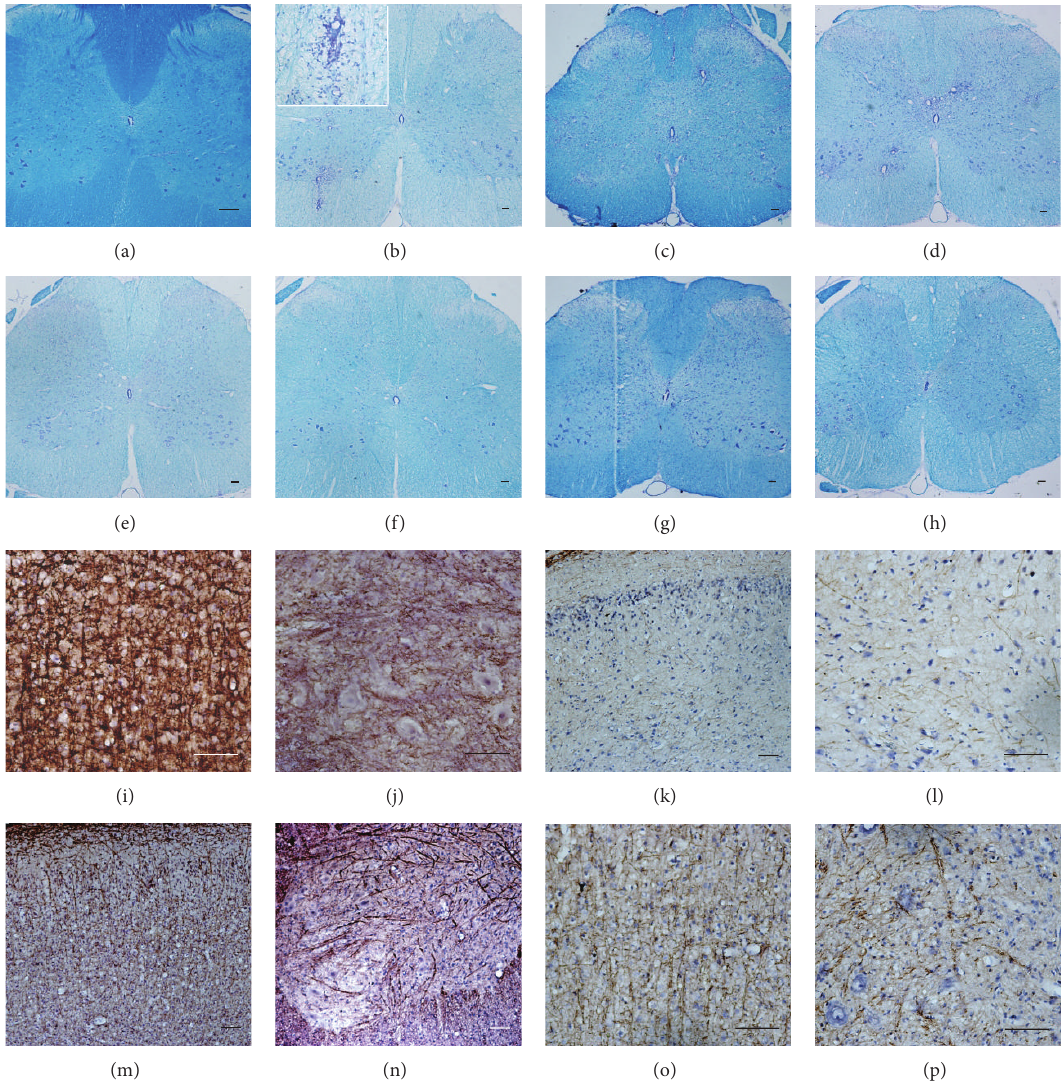
Figure 4: Luxol fast blue staining and MBP immunostaining for spinal cord and cerebral cortex. ((a)–(h)) C16 treatment prevented demyelination in spinal cord and cerebral cortex both at weeks 2 and 8 after immunization; Luxol fast blue staining; traverse section through the lumbar spinal cord; bar = 100 𝜇 m. At week 2 after immunization, normal rats (a), vehicle control rats (b) (inserted image depicting the inflammatory cells infiltrated demyelination area in anterior funiculus), 2 mg/per day C16 treated EAE rats (c) and C16 late treated EAE rats (d). At week 8 after immunization, vehicle control rats (e), 0.5 mg (f) and 2mg (g)/day C16 treated EAE rats, and C16 late treated EAE rats (h). ((i)–(p)) C16 treatment prevented demyelination in spinal cord and cerebral cortex both at weeks 2 and 8 after immunization,